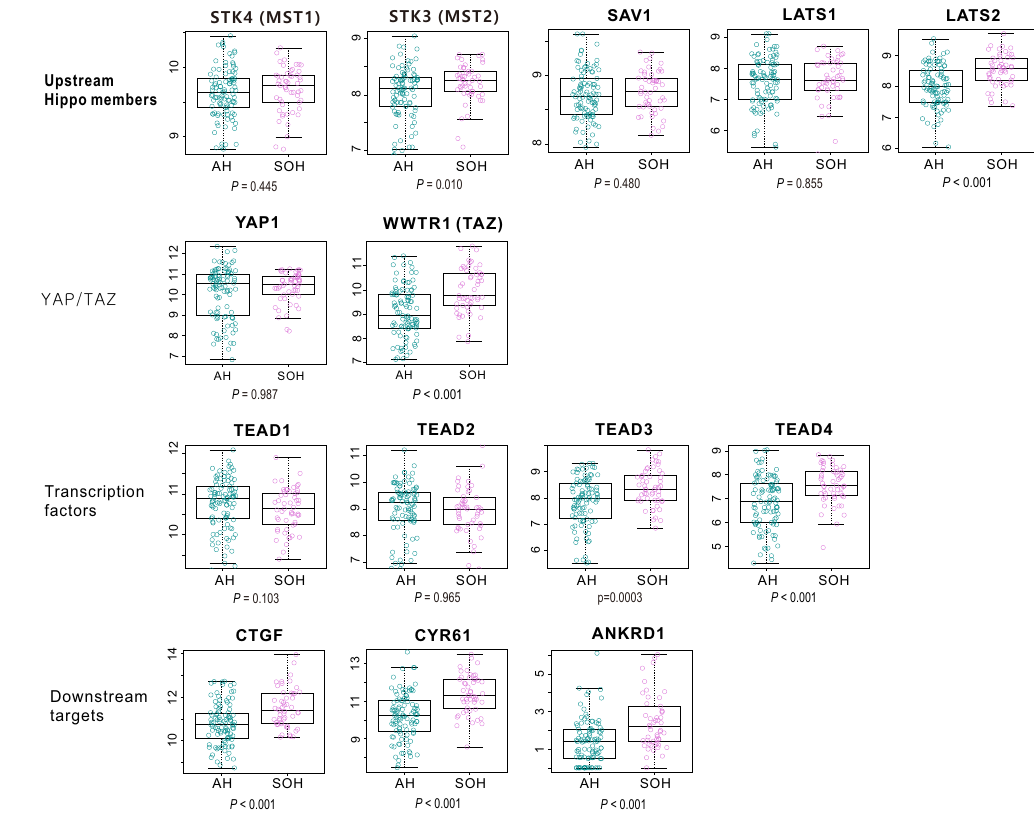
Figure 3. Di ff erential gene expression levels of Hippo–YAP pathway-related genes in The Cancer Genome Atlas. The expression level of TAZ was elevated in the silence of Hippo (SOH) subgroup, although the gene expression level of YAP1 did not di ff er between the SOH and active Hippo (AH) subgroups. The SOH subgroup showed higher levels of TEAD3 and TEAD4 gene expression. Above all, the expression level of CTGF and CYR61 , the most reliable and well-known downstream targets of YAP1 , were markedly increased in the SOH subgroup. Di ff erential gene expression of upstream members of Hippo pathway showed MST2 and LATS2 are upregulated in SOH subgroup revealing that these genes are not responsible for Hippo pathway